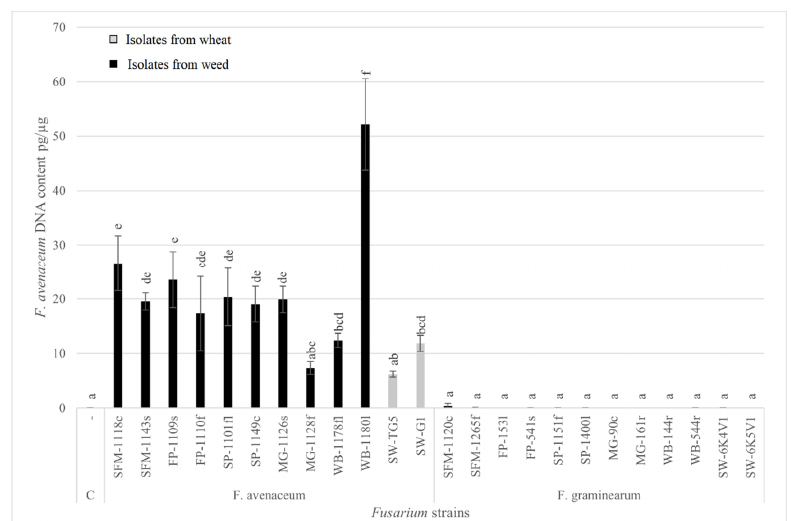
Figure 1. The DNA content of the pathogen F. avenaceum ( F. avenaceum DNA pg/plant DNA μ g) (±SEM) in spring wheat grains inoculated with different strains of F. avenaceum and F. graminearum from alternative host weeds and the main host wheat (values with different letters (a–f) indicate statistically significant differences ( p < 0.05) between study treatments, C—water inoculated control).